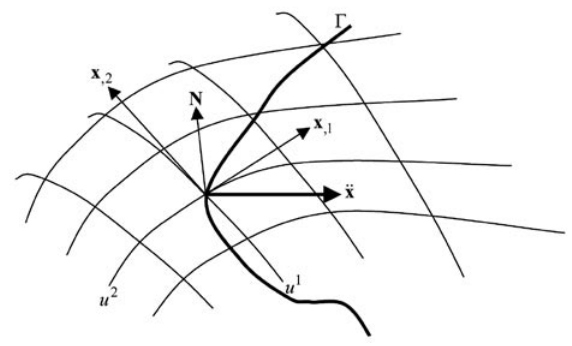
Figure 7 The curvature vector . The normal curvature of the surface at x in the direction of Γ is given by equation